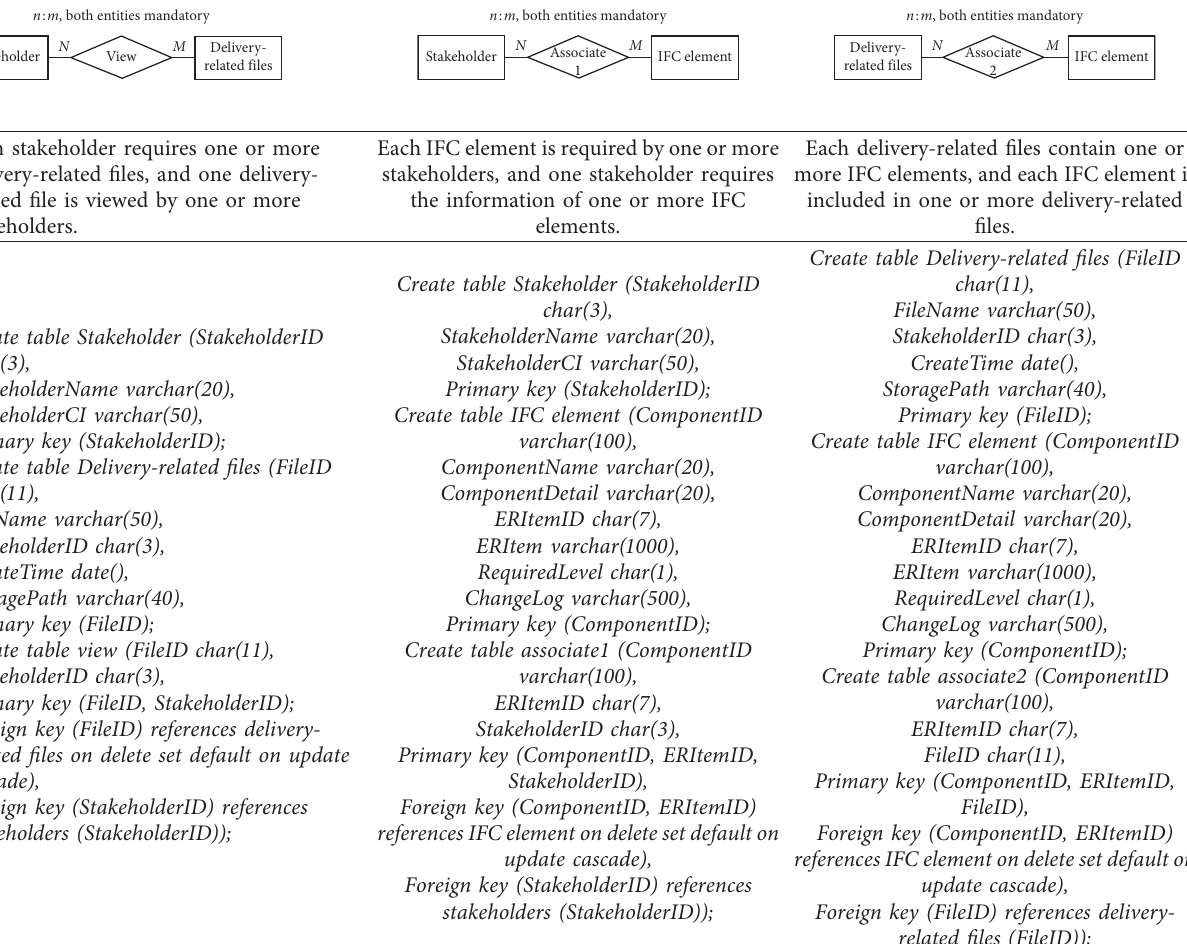
Table 9: Relationship between two